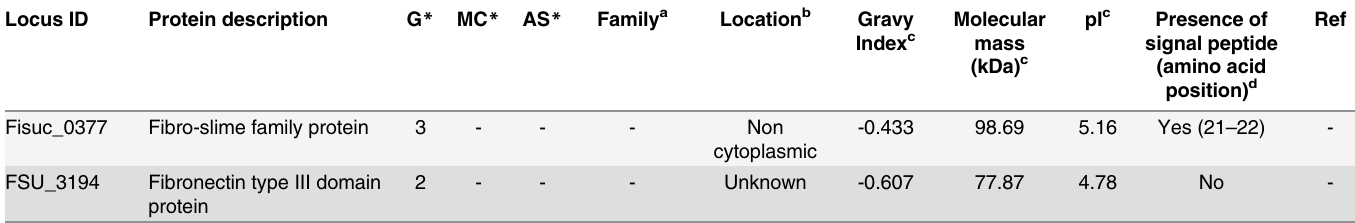
* G – glucose; MC – microcrystalline cellulose; AS – acid swollen cellulose. The numbers under these columns represent the number of unique valid peptide sequences on which protein identi fi cation is based.